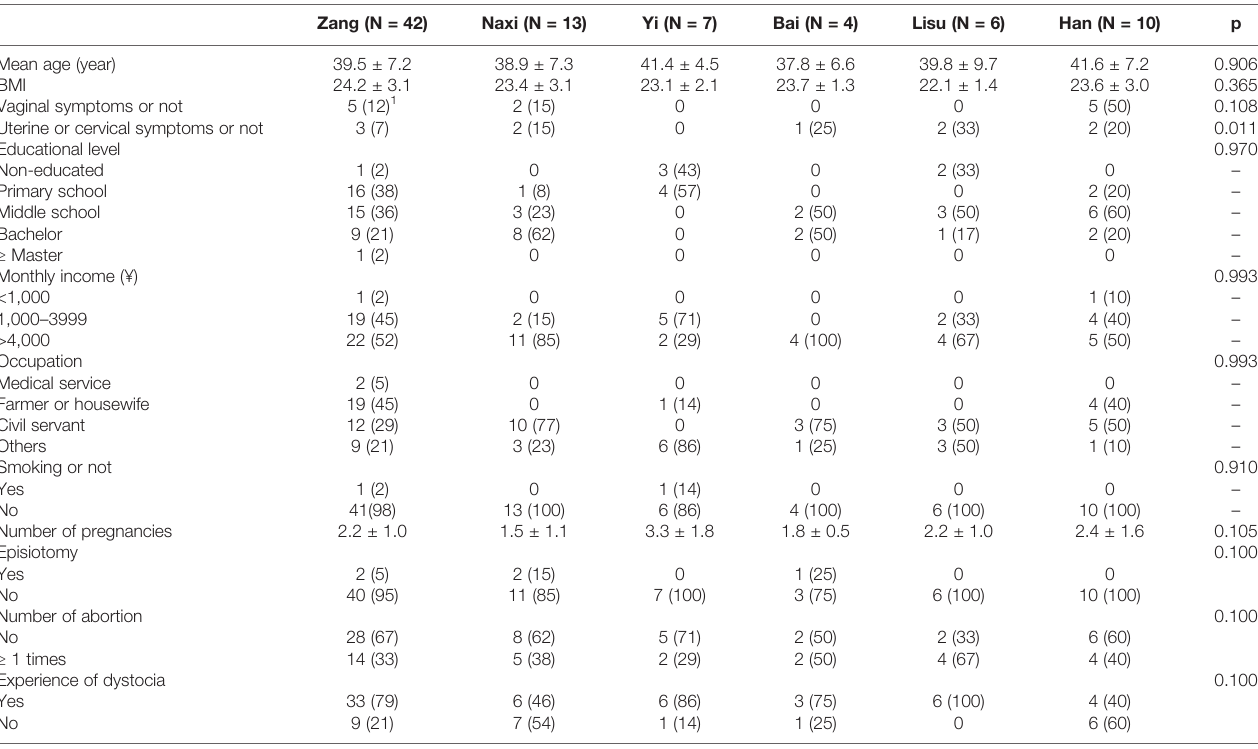
TABLE 1 | Demographics of